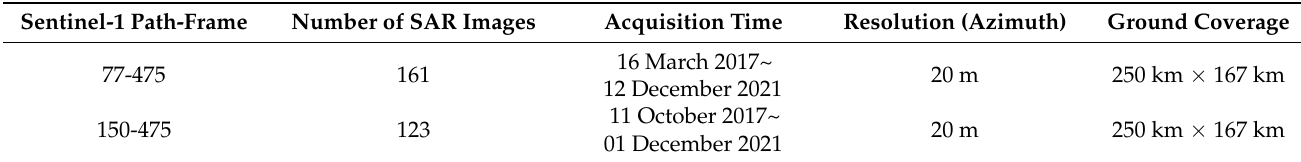
Table 3. Sentinel-1